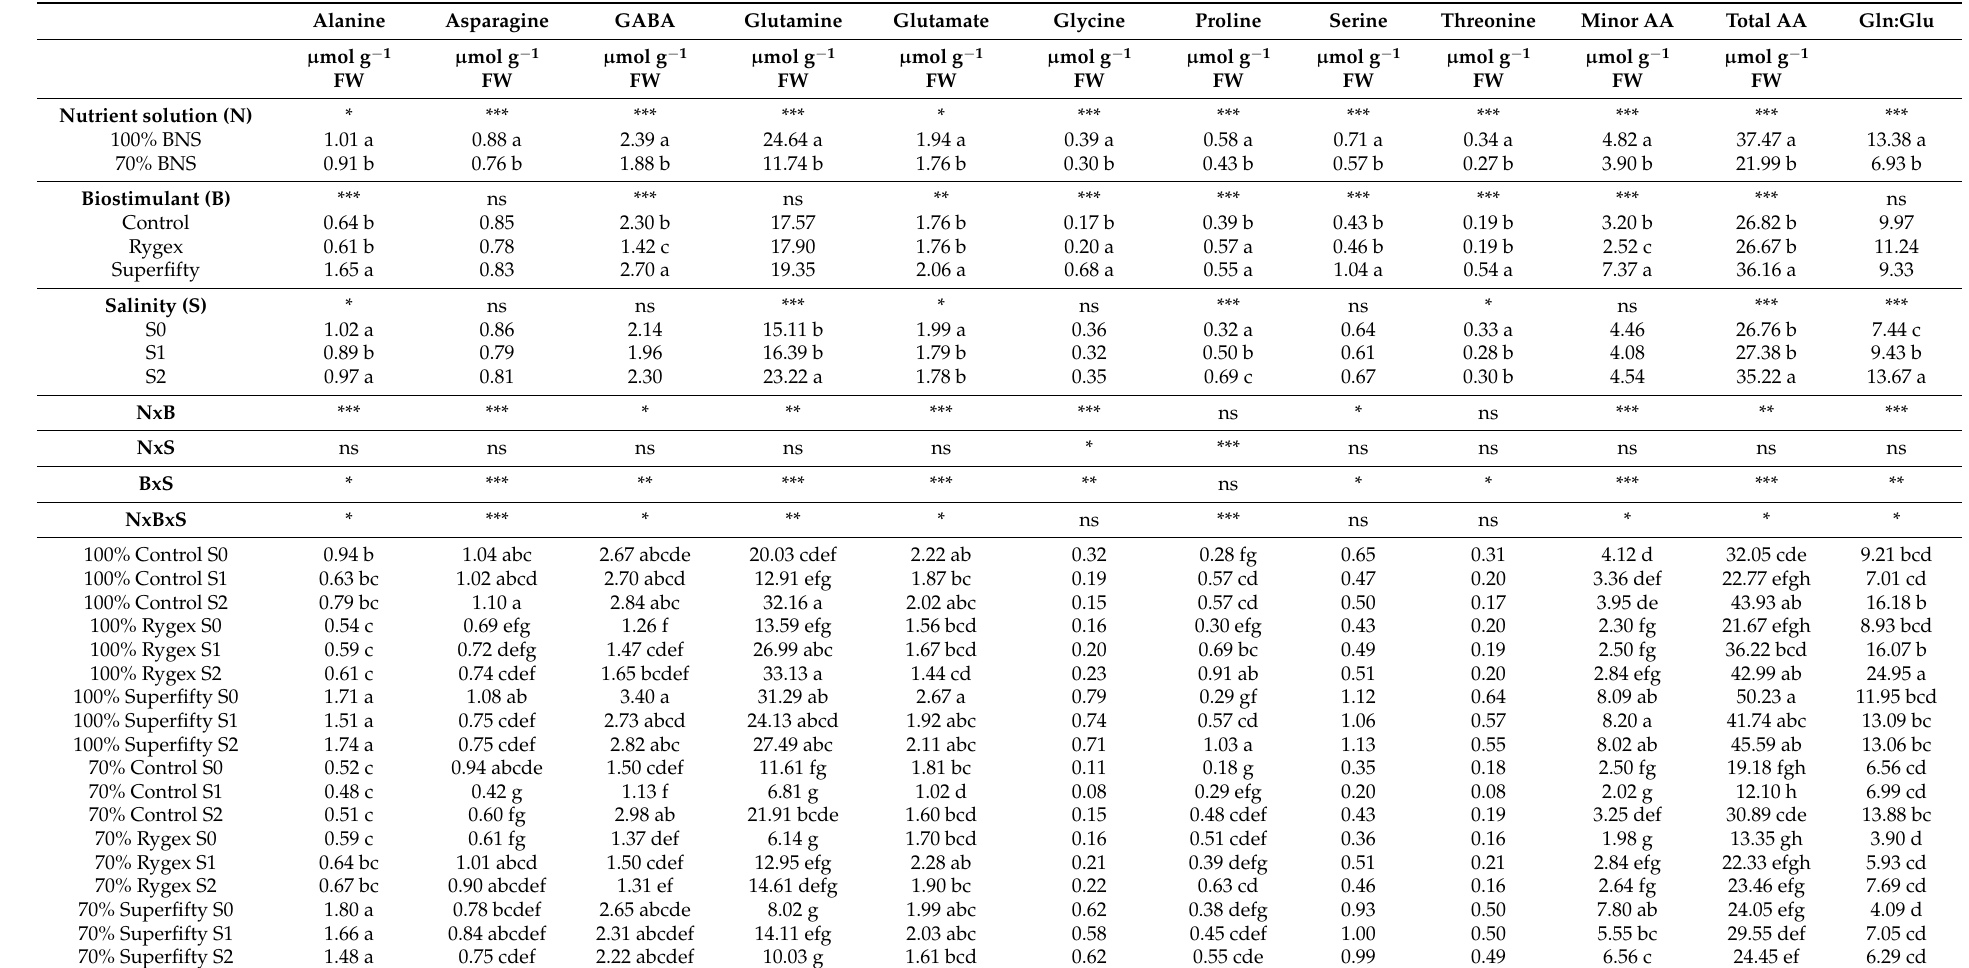
Table 5. Significance of the main factors and their interactions on content of leaf free amino acids of MicroTom plants. Experimental design is as in Table